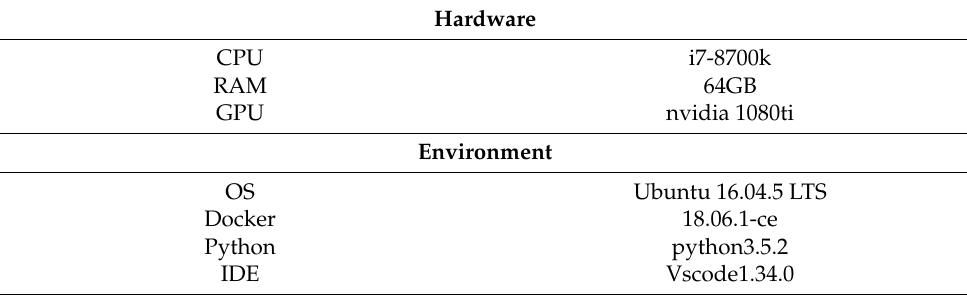
Table 1. Experiment Environment and